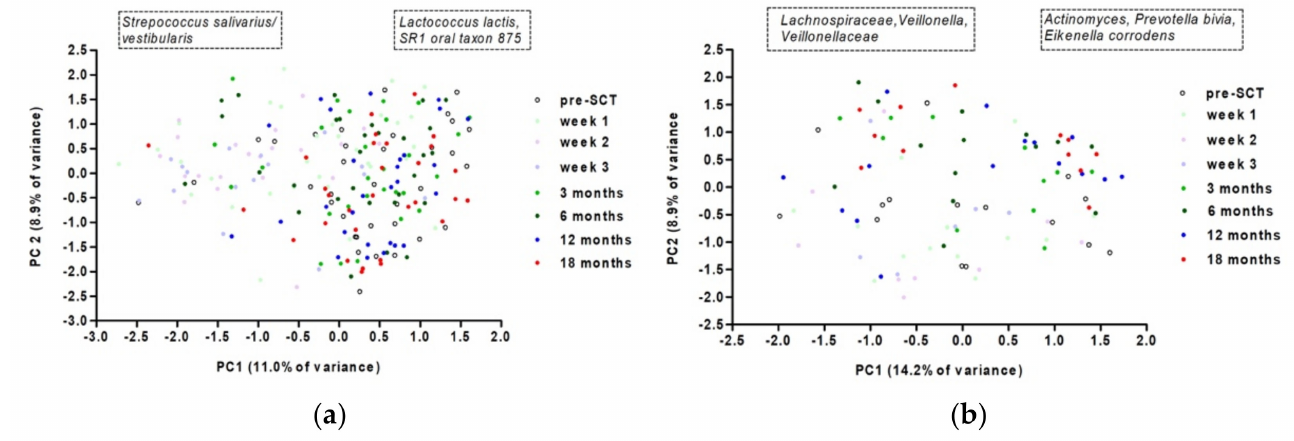
Figure 6. Principal component analysis on oral microbiome over time for patients who did not ( a ) and did ( b ) experience oral GVHD. Left box—more abundant taxa at low values of PC1 loadings, right box—at high